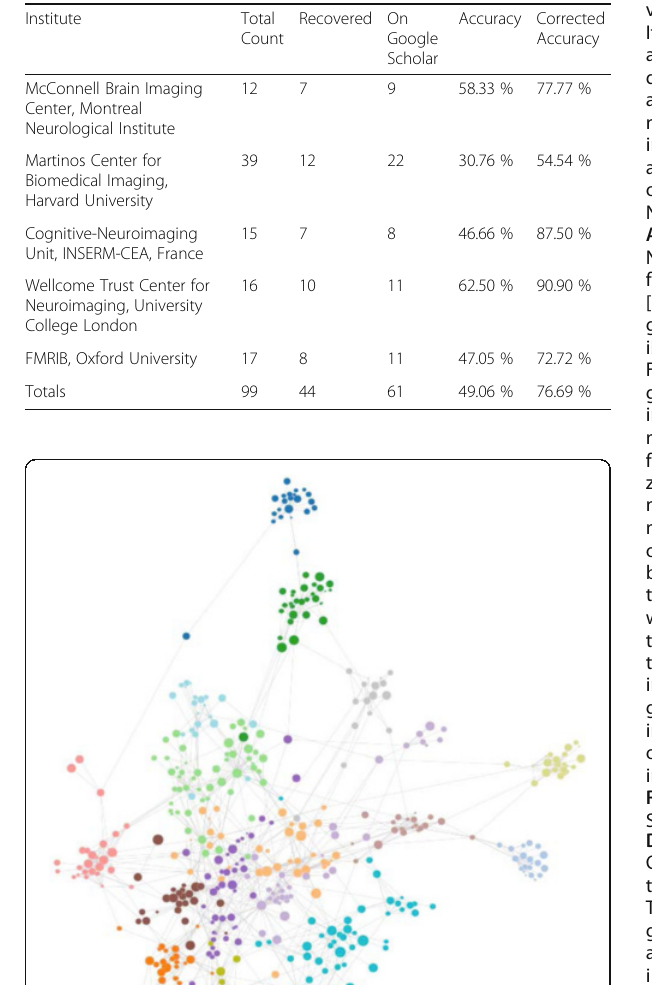
Table 2 (abstract A6). Completeness study: accuracy between the faculty roster of five major neuroimaging institutes and the neuroimaging network